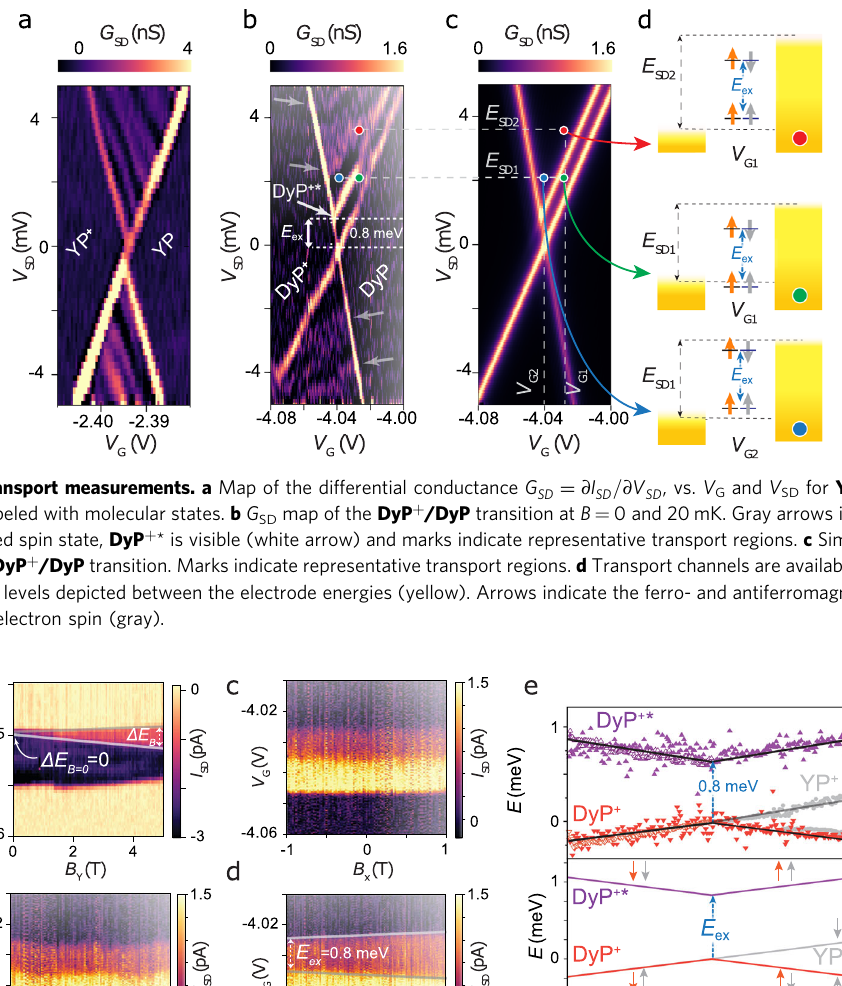
V = 1.5 mV. x , acquired at SD